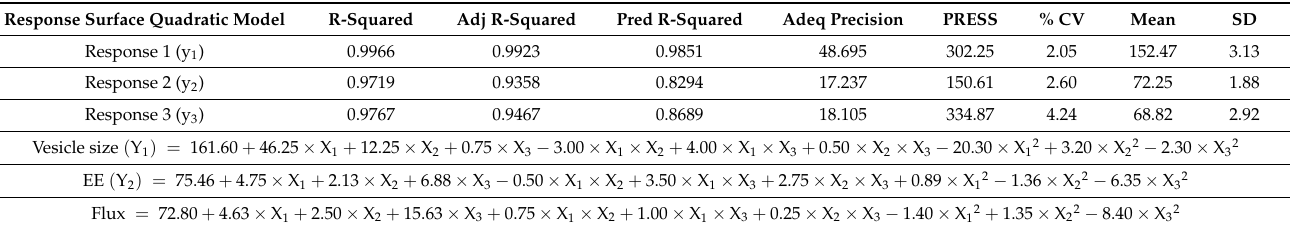
Figure 2. The linear correlation plots ( A , C , E ) between predicted vs. observed values and cor- responding residual plots ( B , D , F ) for responses vesicle size, entrapment efficiency, and flux of plumbagin (PLM). Table 3. Regression analysis summary for various responses Y 1, Y 2 , and Y